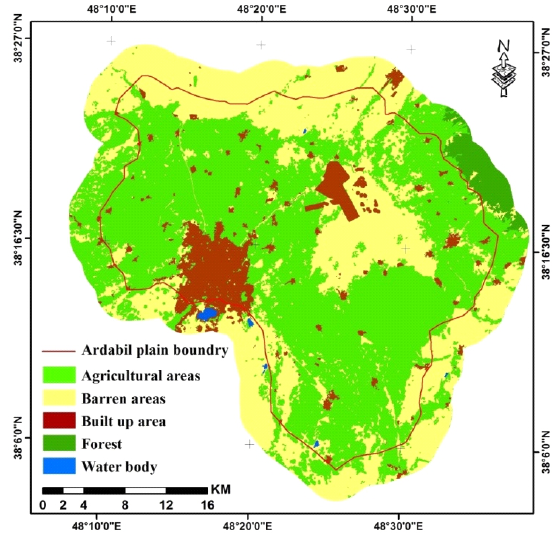
Fig. 9: Simulated land use map for 2014